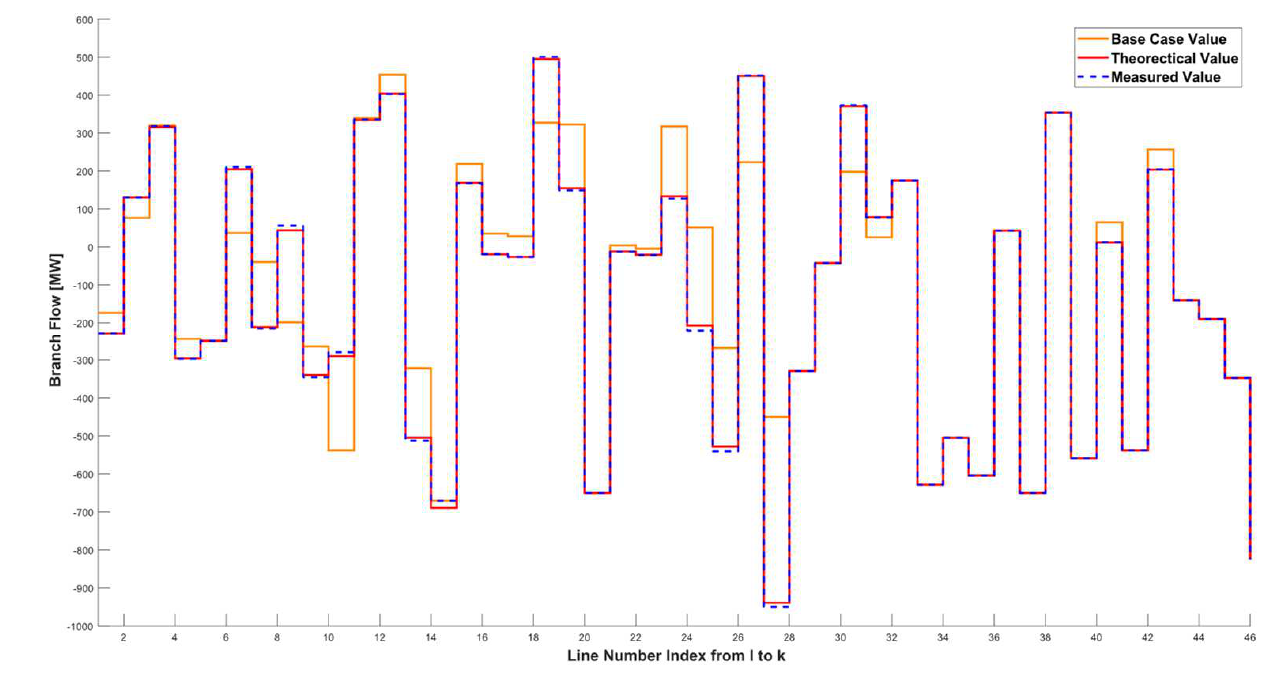
Figure A1. Sensitivity-based analysis and measured MW flow data comparison.